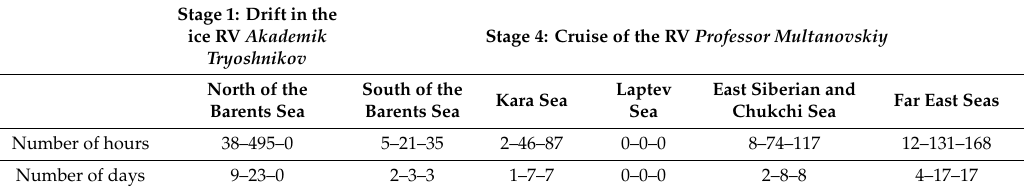
Table 1. Number of hours and days of measurements aerosol characteristics ( τ a – N A – M BC ) in expeditions